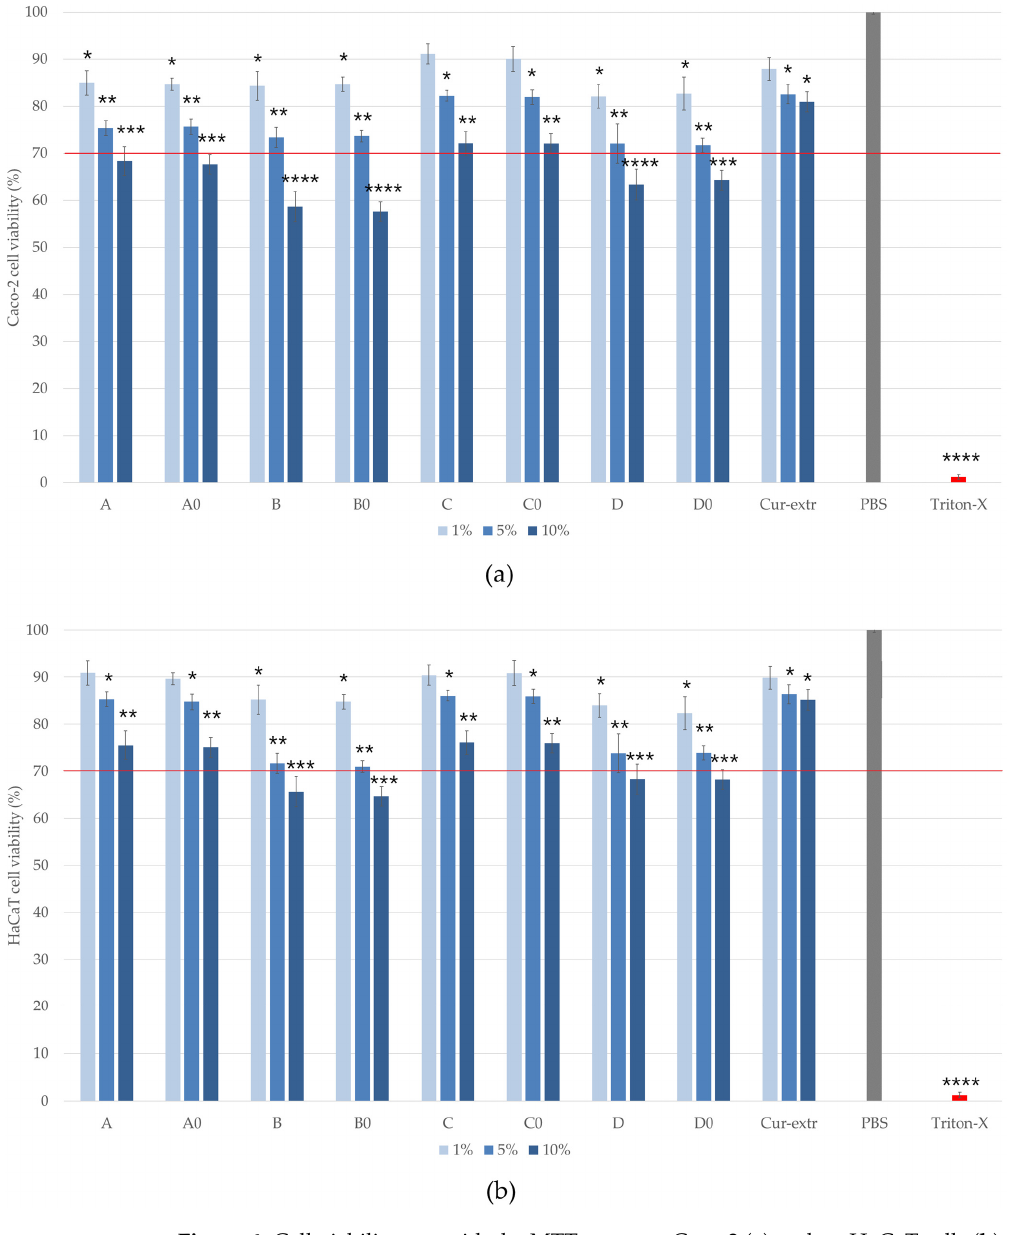
Figure 6. Cell viability test with the MTT assay on Caco-2 ( a ) and on HaCaT cells ( b ) after incubation with the formulations for 2 h. Cell viability is expressed as the percentage of negative control (PBS), which was treated only with PBS. The positive control was Triton X 100 (10% w/v ), which had significantly lower cell viability results compared with the untreated control. Each data point represents the mean ± S.D. and n = 12. Ordinary one-way ANOVA with Dunnett’s multiple comparison test was performed to compare the different formulations with PBS. The *, **, ***, and **** indicate statistically significant differences at p < 0.05, p < 0.01, p < 0.001, and p < 0.0001.